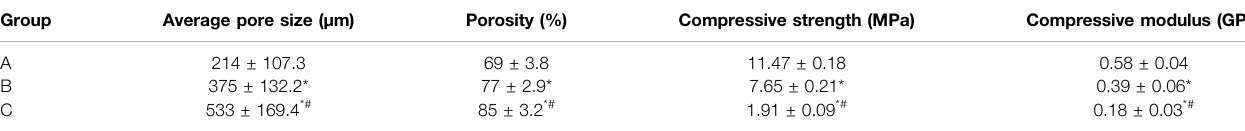
TABLE 3 | Mean pore size, porosity, and mechanical property of the three groups n-HA/PA66 scaffolds. Group